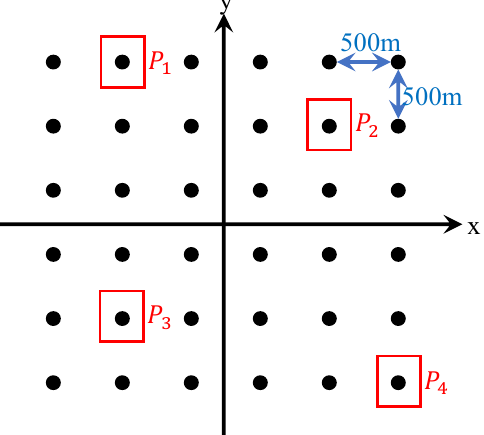
Figure 5. Spatial distribution of point targets.